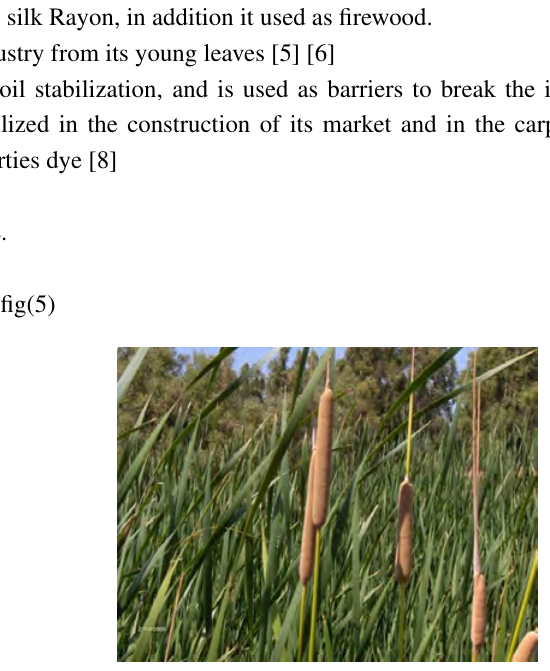
Figure 5. Typha (local emerged plant